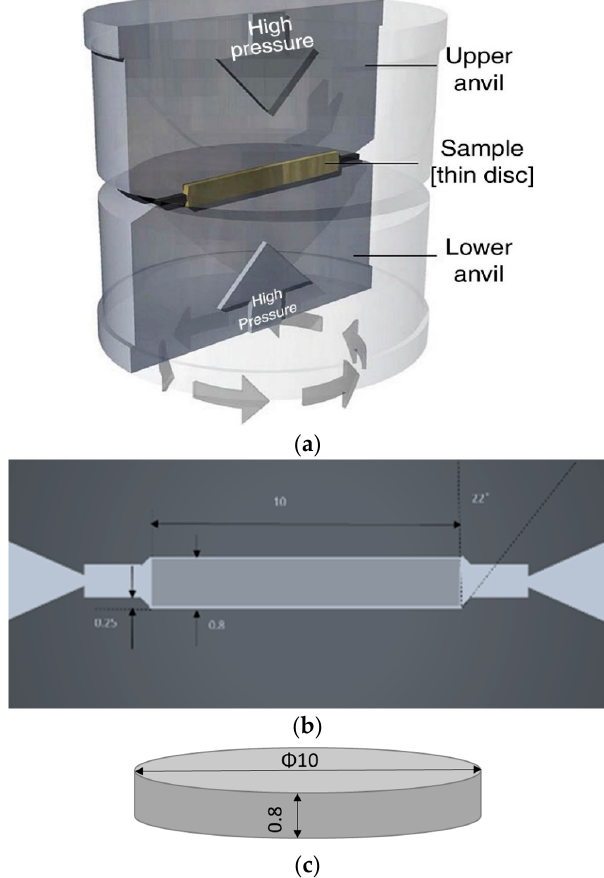
Figure 1. High pressure torsion (HPT) process with a hydrostatic pressure and torsional stress applied to the sample disc [11]. ( a ) A schematic of the HPT rig; ( b ) A disc sample held in the anvils; ( c ) A disc sample.